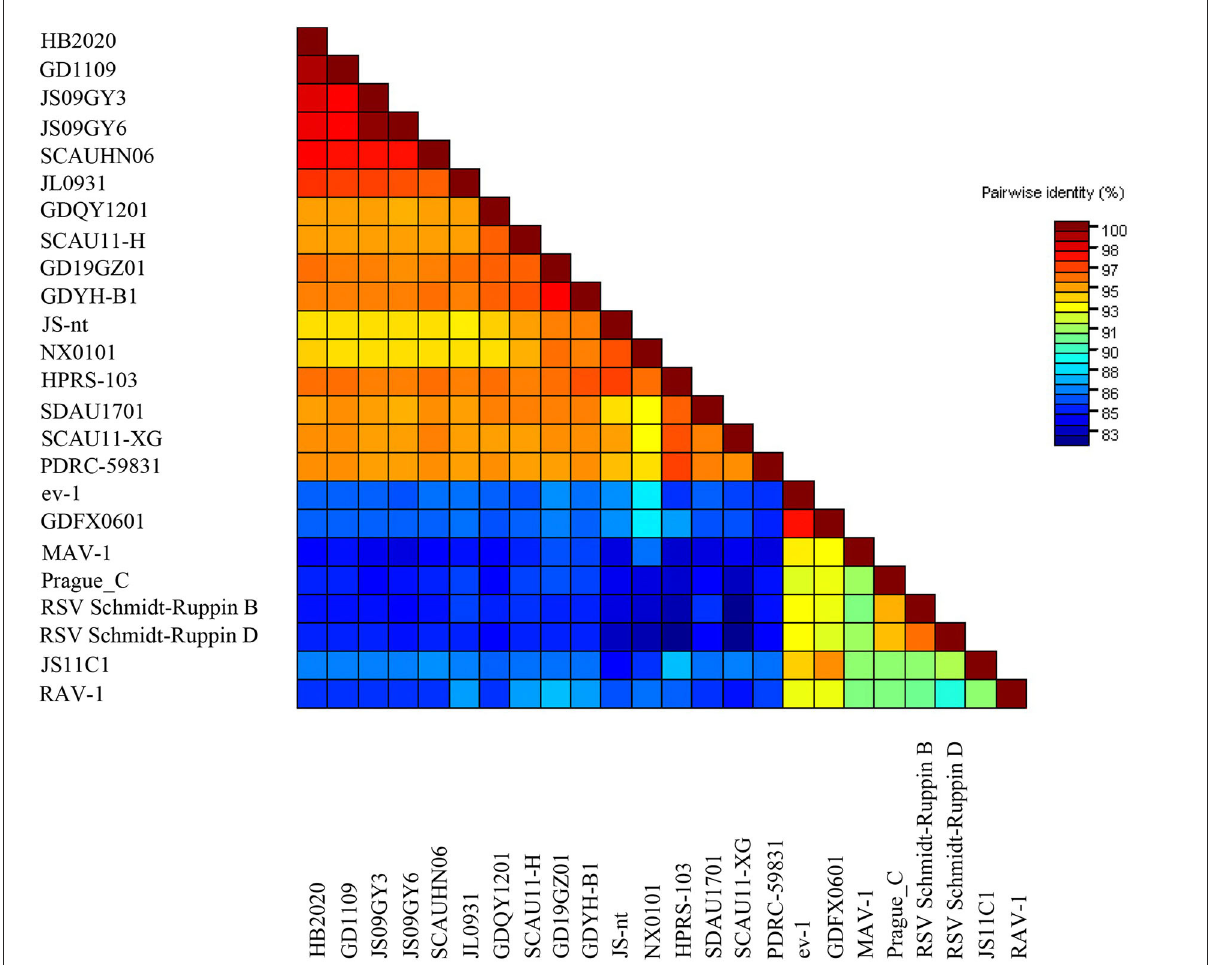
FIGURE3 The pairwise identities plot of the entire gene for the HB2020 isolates reported in this study (red colored), aligned by ClustalW and displayed by the Sequence Demarcation Tool (SDT) software.